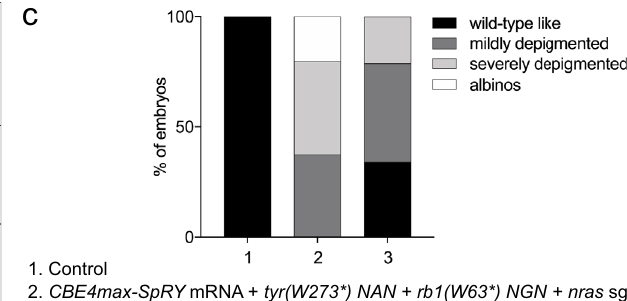
Pool of 68 severely depigmented